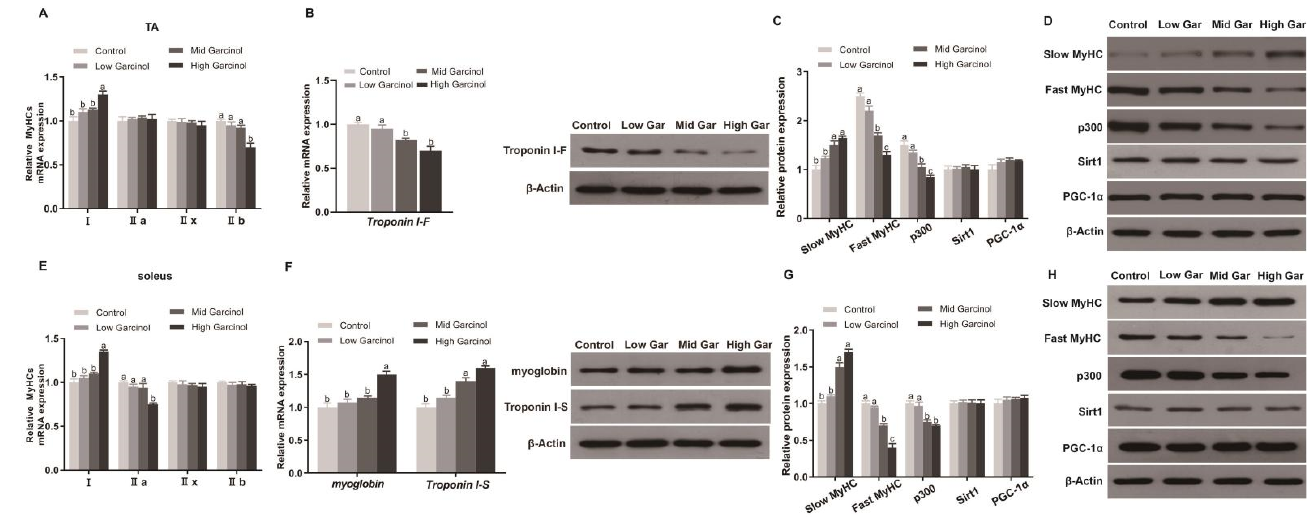
Figure 2. Real-time PCR was performed to quantify the relative mRNA expression of MyHC in TA ( A ) and soleus ( E ) muscle. Effects of dietary garcinol on the relative mRNA and protein expression of Troponin I-F in TA muscle ( B ), myoglobin and Troponin I-S in soleus muscle ( F ). Slow MyHC, Fast MyHC, p300, Sirt1 PGC-1 α protein expression in TA ( C , D ) and soleus ( G , H ) muscle. Data are shown as the mean ± SE, n = 10. Means for a given protein without a common letter differ, p < 0.05.